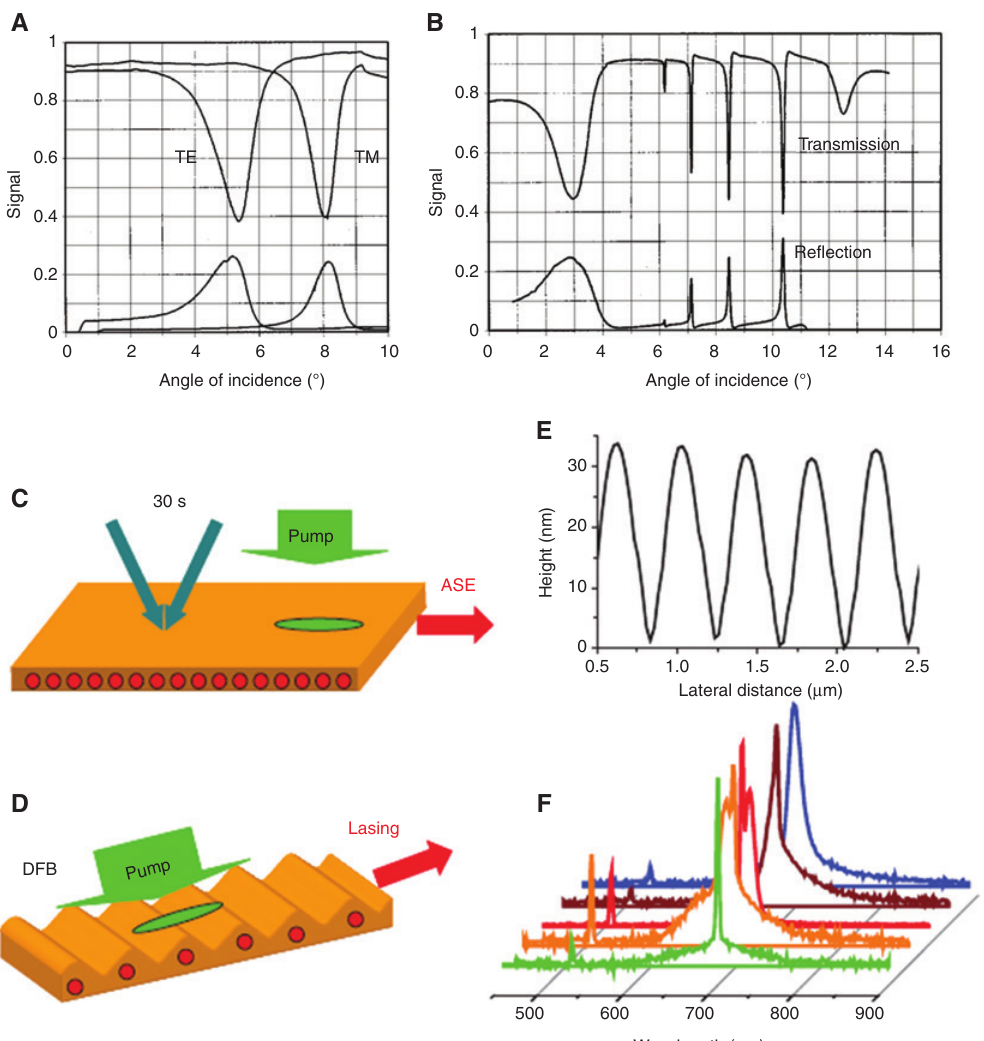
Figure 13: Applications of the SRGs as diffractive optical elements. (A) Normalized angular transmission (top) and reflection (bottom) spectra of a TM and a TE polarized He-Ne beam propagating through a 500-nm-thick azopolymer layer presenting an SRG with pitch of 390 nm. (B) When the azopolymer layer is deposited onto a polyamide wave- guide, the angular spectra for the TE polarized beam present sharp features, demonstrating a resonant coupling of the light in waveguided modes. Reprinted from Ref. [219] with permission from AIP Publishing. (C–D) A distributed feedback (DFB) laser fabricated by a dye-doped structured azomaterial film. The SRGs inscribed onto the film provide the optical feedback that switches the amplified spontaneous emis- sion (ASE) in a laser emission. (E) AFM height profile of SRGs inscribed on the emitting material blend. (F) Laser emission spectra obtained by tuning the SRG periodicity for different dyes included into the azomaterial. Reproduced from Ref. [225] with permission from John Wiley and Sons, copyright